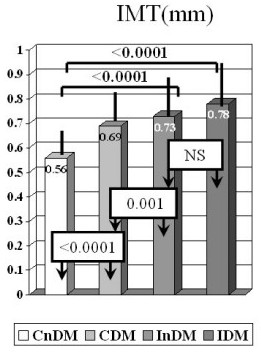
Bar graphs representing mean intimal-medial thickness (IMT) for the four groups of patients; CnDM-Caucasian non-diabetics, CDM-Caucasian diabetics, InDM-indigenous non-diabetics, IDM-indigenous diabetics.